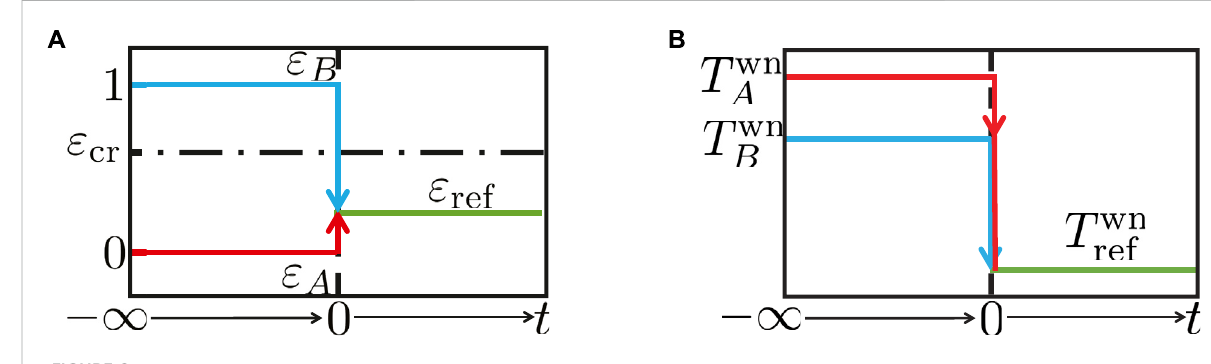
FIGURE 8 Scheme of the protocol for SME. (A) Choice of the splitting parameters ε . (B) Choice of the noise temperatures T wn .